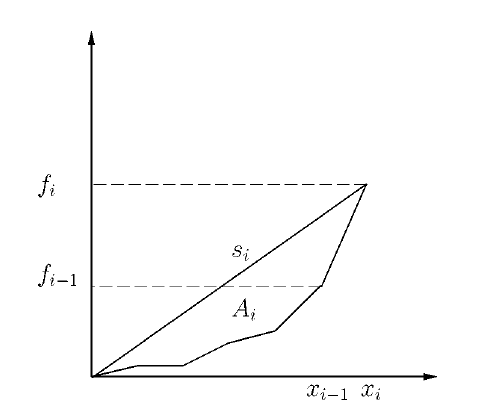
Fig. 3. The polygonization method of Wall and Danielsson.